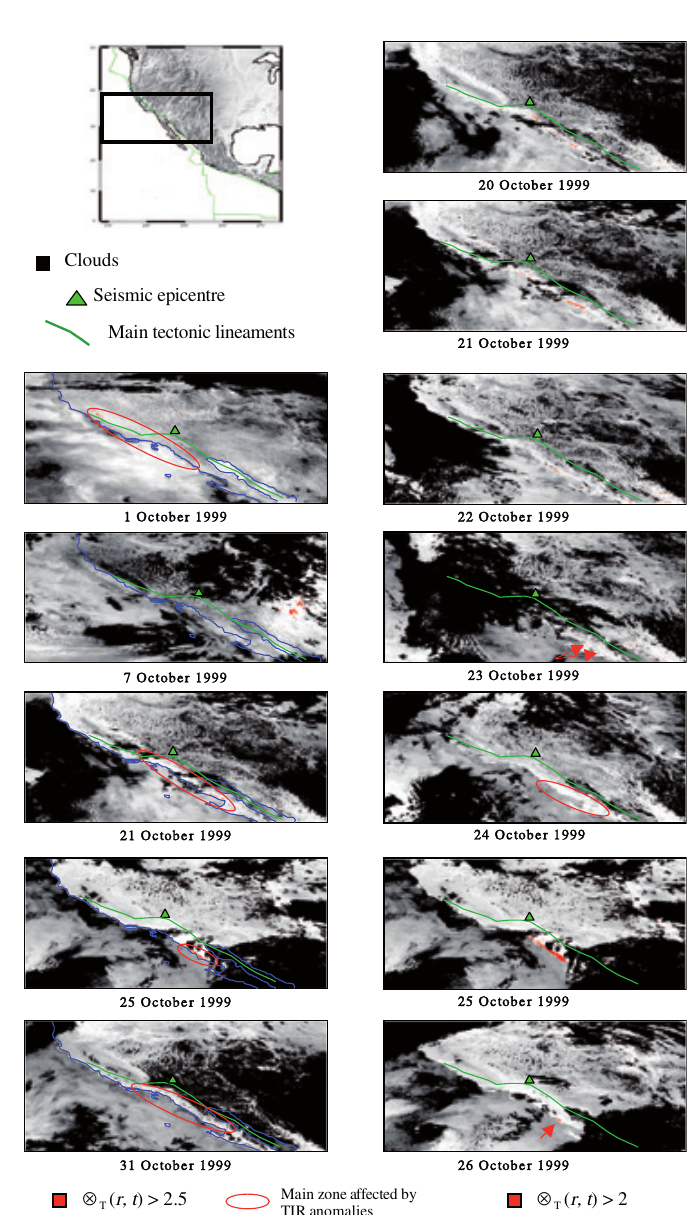
Fig. 3. The RST approach applied to geostationary satellite data (GOES). Results of the analysis of the daily ⊗ ∆ T ( r, t ) index on the epicentral area before and after earthquake ( M s =7.4) of Hector Mine (California) occurred on October 16th 1999. Left side: results of the analysis performed on GOES images collected from October 1st to 31st with pixels having ⊗ ∆ T ( r, t ) >2.5 depicted in red. Right side: results of the analysis performed from Oc- tober 16th to 26th with pixels having ⊗ ∆ T ( r, t ) > 2 depicted in red. Note that, images corresponding to mostly overcast days or without any thermal anomaly on the scene are not shown in the figure (see